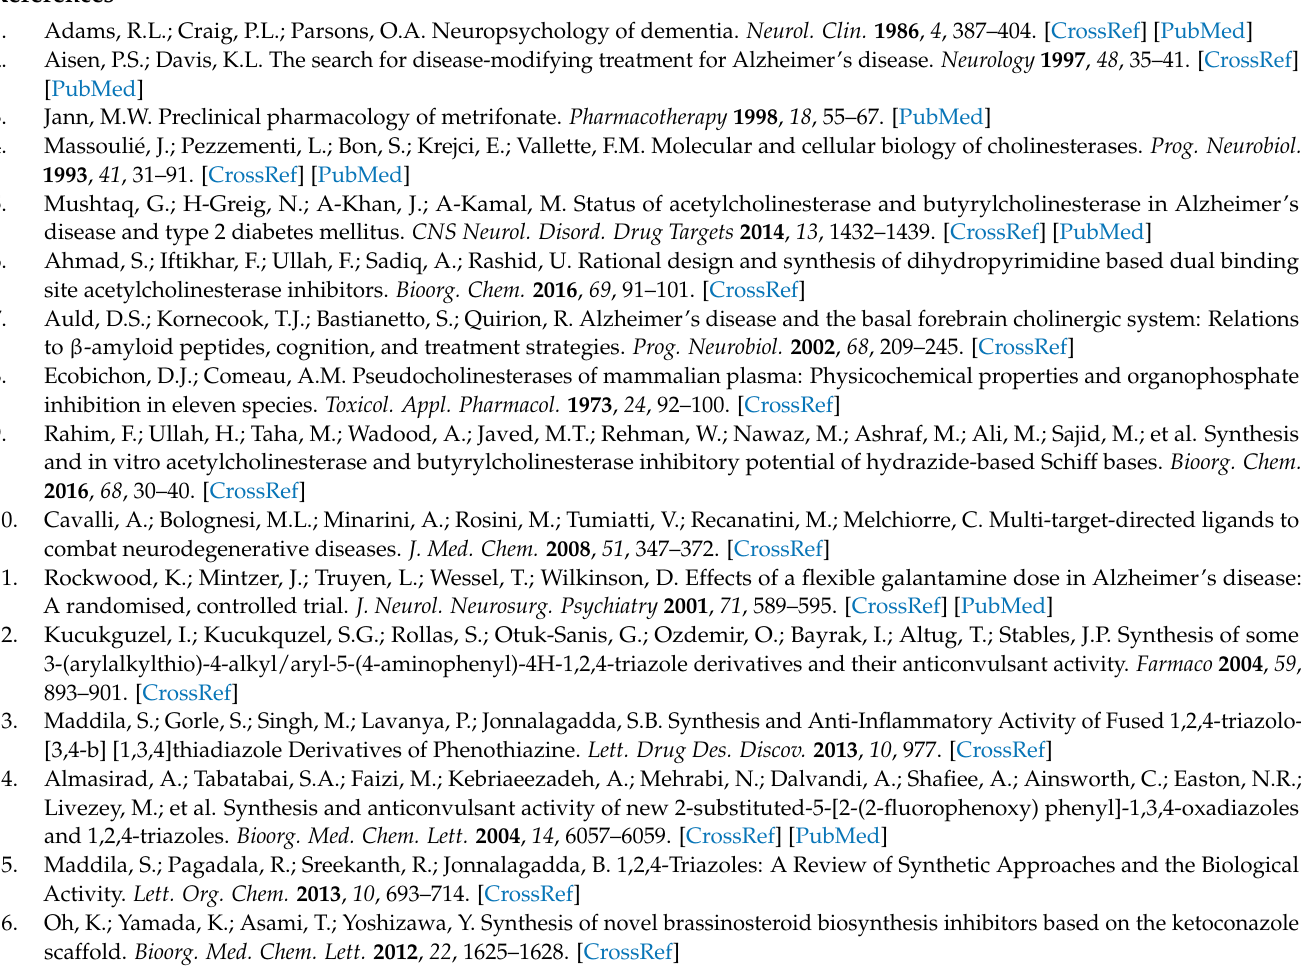
6b . Figure S2. Proton NMR spectrum of compound 6d . Figure S3. Proton NMR spectrum of compound 6i . Figure S4. Proton NMR spectrum of compound 6j